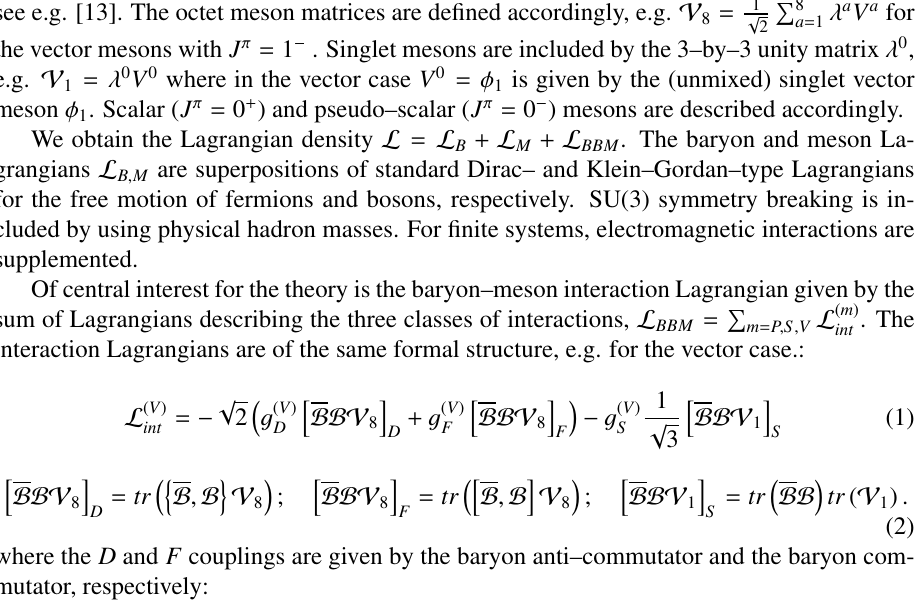
fi ned by the SU(3) rules introduced by de Swart [18]. Denoting the eight Gell–Mann SU(3) matrices by λ a , the baryons are represented as usual by the 3–by–3 matrix B = 1 see e.g. [13]. The octet meson matrices are de fi ned accordingly, e.g. V 8 = 1